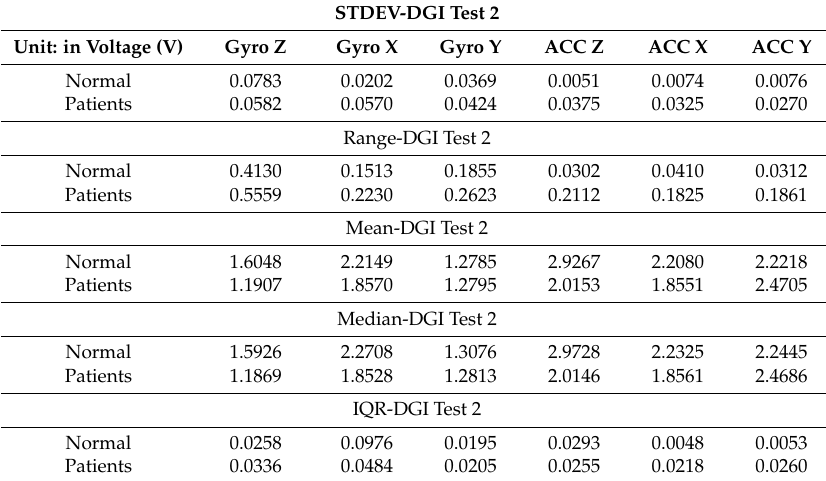
Table 2. The standard deviation (STDEV), range, mean, median and IQR (interquartile range) of DGI Test 2 data averaged for all normal subjects vs. patients.